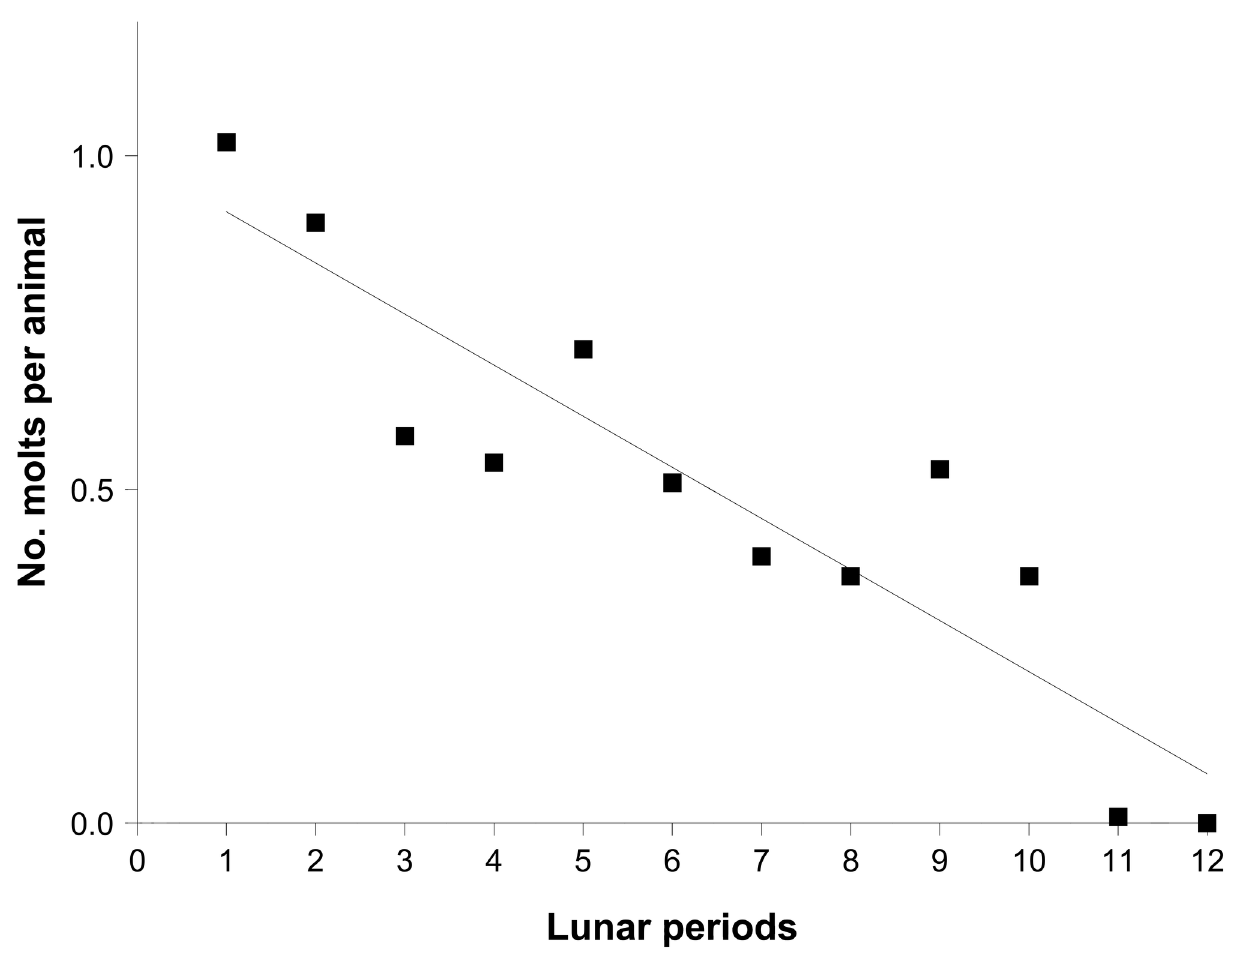
Figure 5. Number of molts per animal during the successive lunar cycles of the one-year experimental period (experiment 2). Linear regression line is